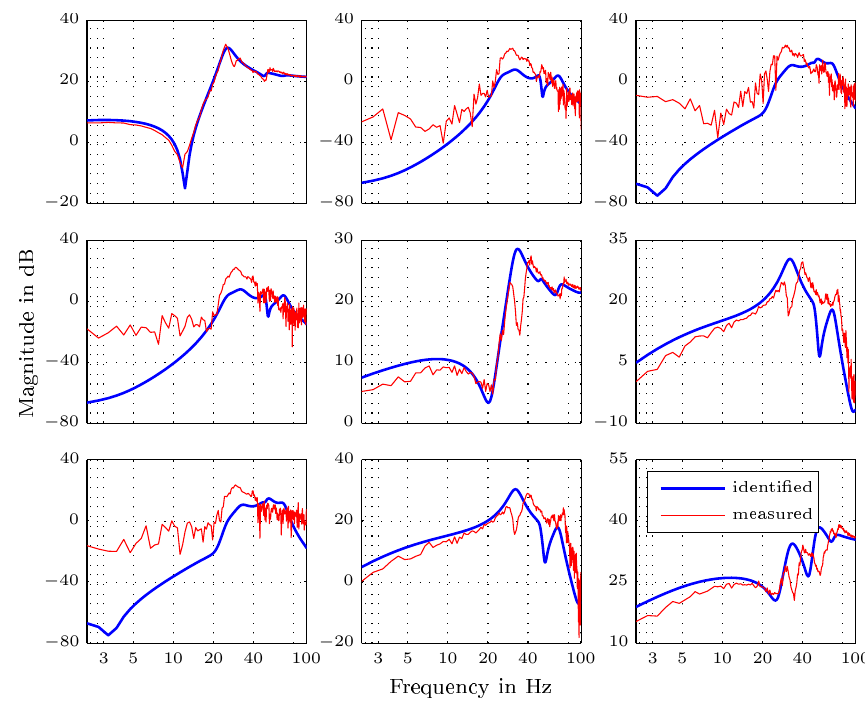
Figure 7. Comparison of the non-parametric FRM ˆ G [ qP 1 ] and the identified parametric one G [ qP 1 ] .